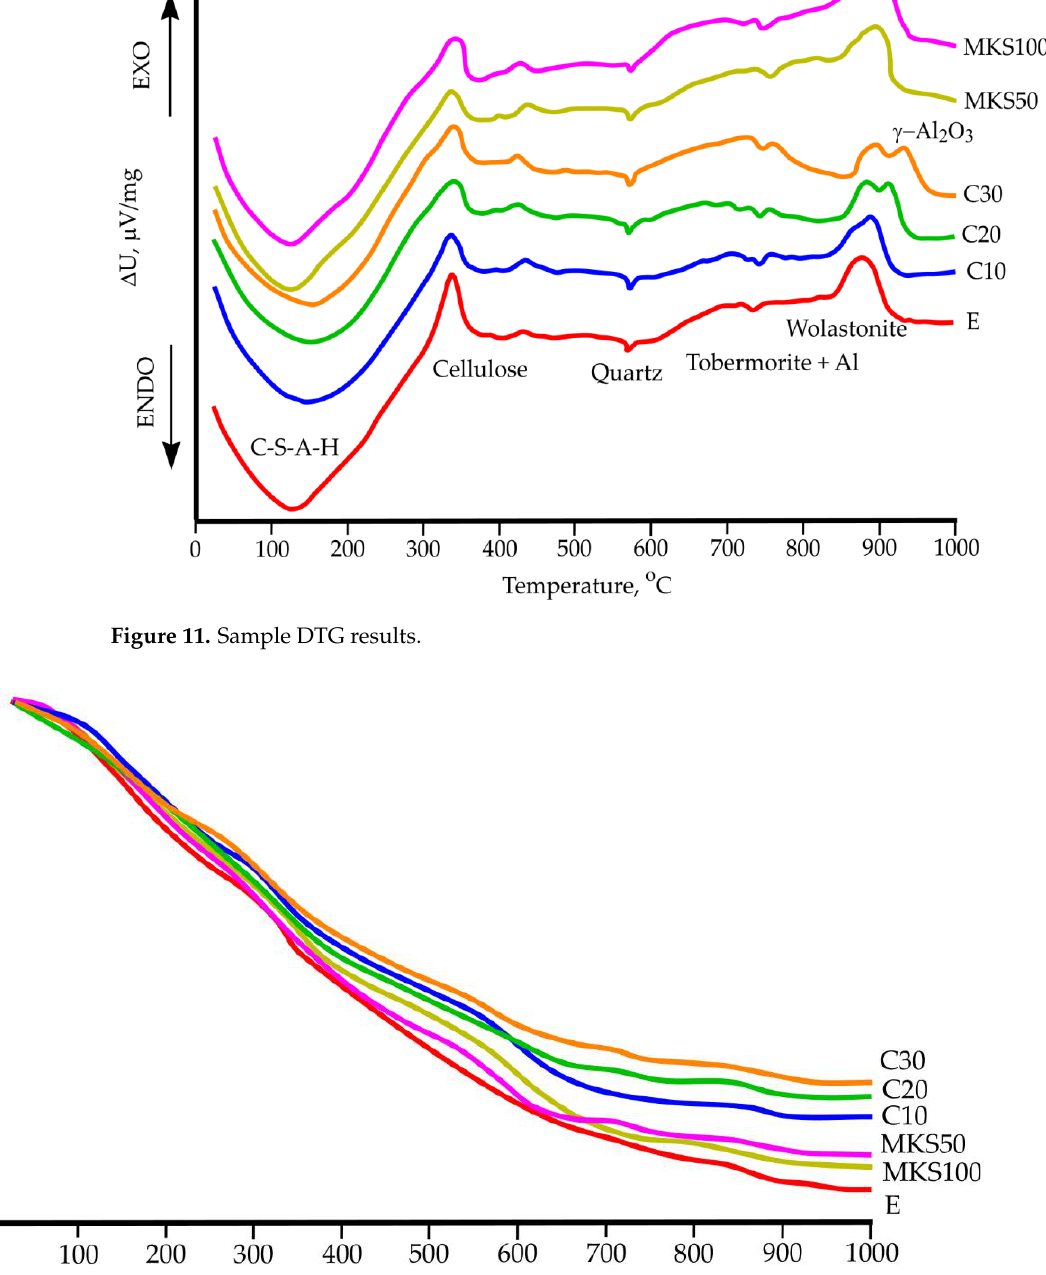
Figure 12. Sample TGA results.